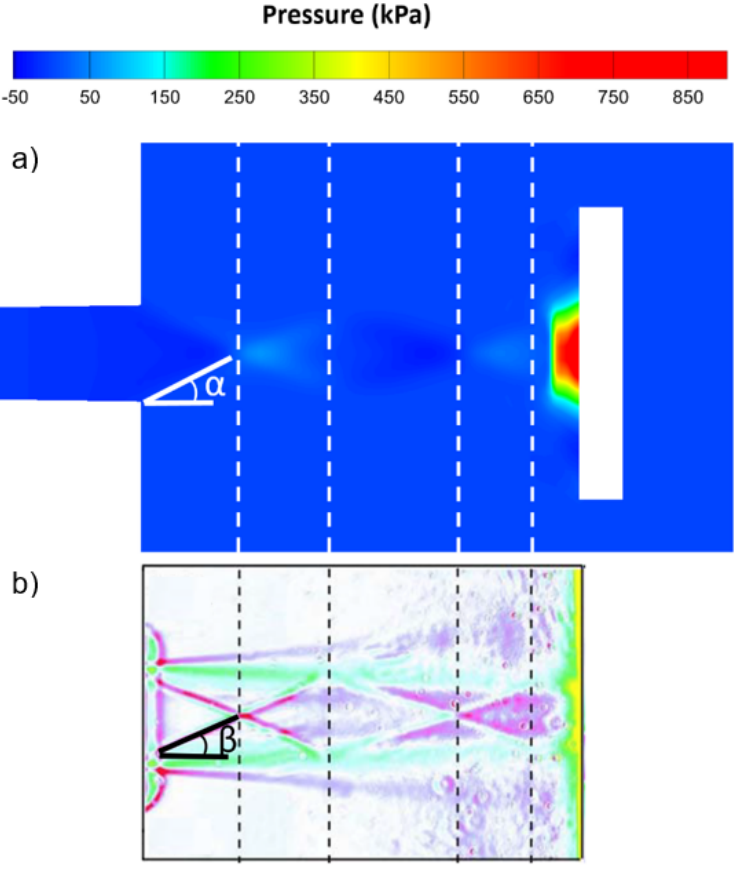
Figure 5. ( a ) Contours of pressure and ( b ) the visualization of shocks for the experiment presented in Samareh et al.’s work (Reproduced from Reference [26] with permission (Copyright Springer 2009)).